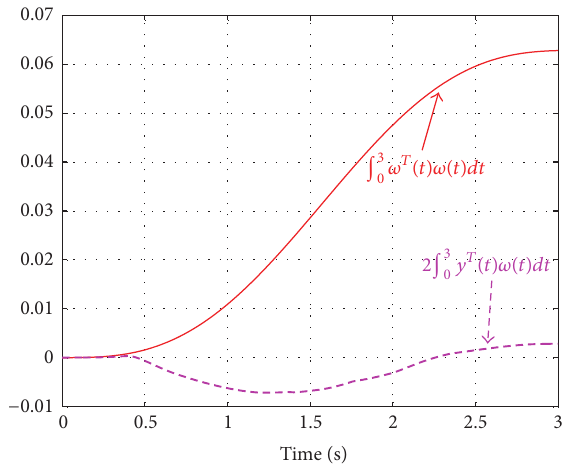
3 𝑦 𝑇 (𝑡)𝜔(𝑡)𝑑𝑡 and ∫ 3 0